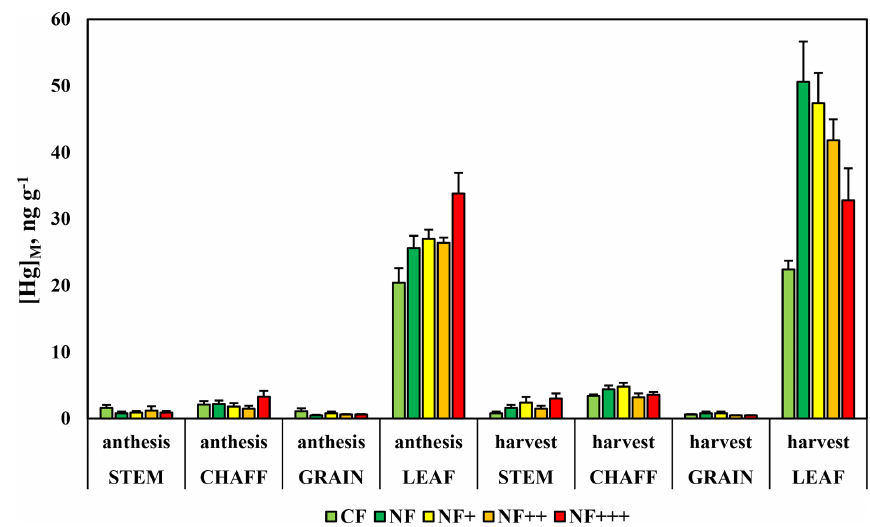
Figure 9. Mass-based concentrations of mercury, [Hg] M , in four fractions of wheat after anthesis and short before harvest. Data are from an ozone experiment with field-grown wheat. CF, charcoal-filtered air; NF, non-filtered air; NF+, NF++ and NF+++, non-filtered air with different levels of ozone added. Error bars show standard deviation for the five replicate experimental chambers per